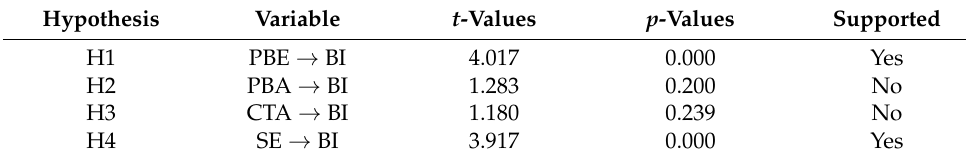
Table 3. Path Coefficients Estimation.